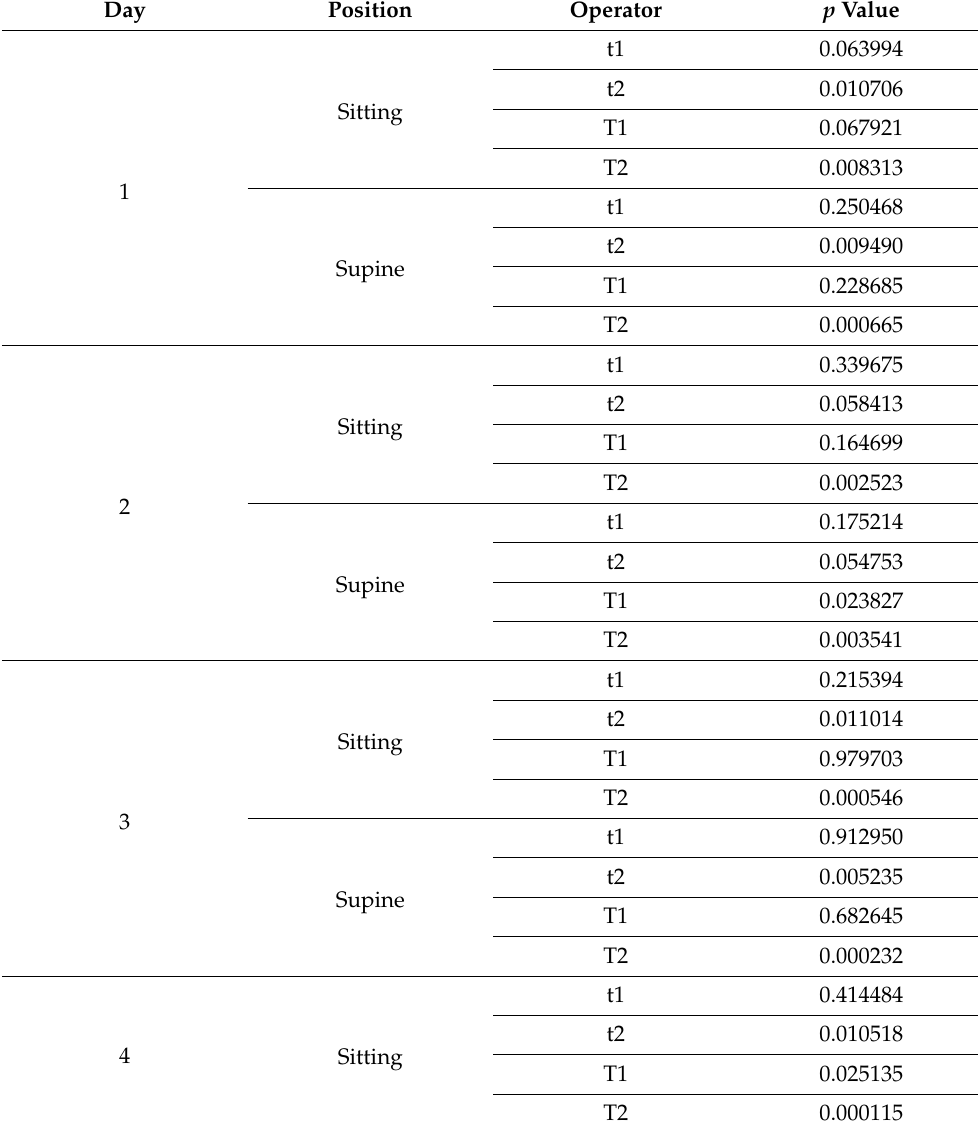
Table 4. One-sample t -test